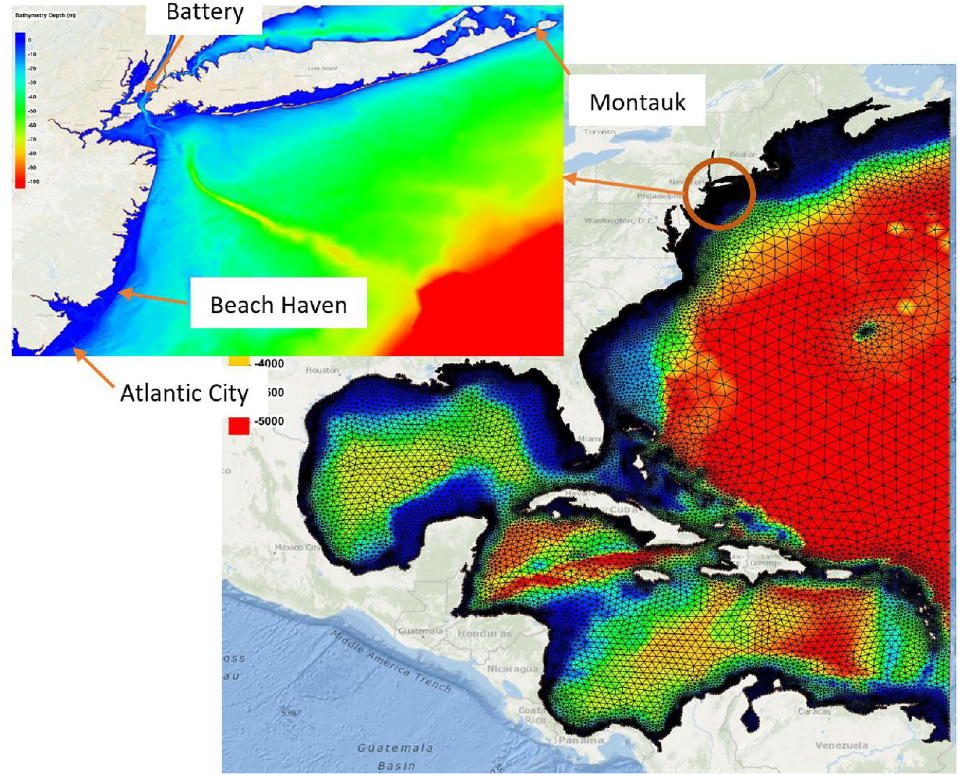
Figure 1. Computational mesh of the ADCIRC + SWAN model used in the present study. The study sites considered in this study are noted in the inset of the figure. The figure was generated using the AQUAVEO-SMS 13.1 software (https:// www. aquav eo. com/ softw are/ sms- surfa ce- water- model ing- system- intro ducti